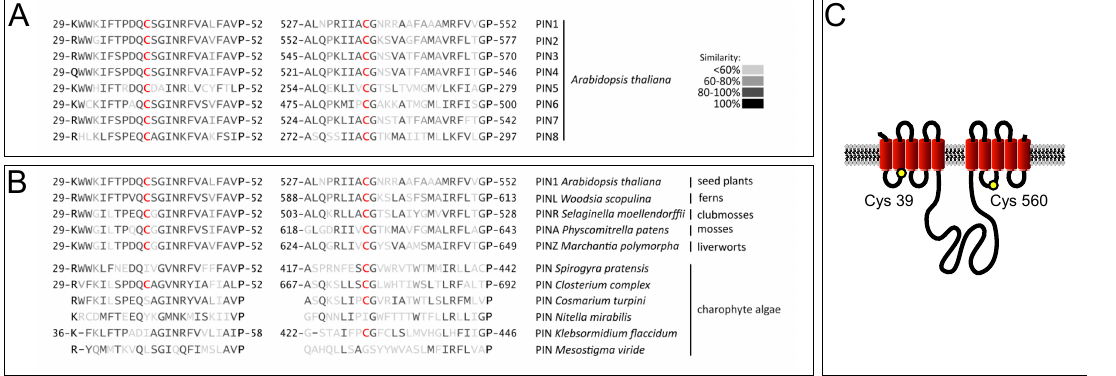
Figure 1. Conservation and predicted localization of conserved PIN cysteines. ( A ) Alignment of Arabidopsis PIN protein domains flanking conserved cysteines. Conserved cysteines are displayed in red; ( B ) Alignment of PIN protein domains flanking conserved cysteines, from representative Embryophyta and charophyte green algae. Conserved cysteines are displayed in red. Lack of indicated amino acid positions denotes incomplete sequences; ( C ) 2-D model displaying potential membrane conformation of PIN2. Red barrels represent predicted transmembrane helices, separated by loop domains (black lines). According to these predictions, both cysteines are facing the cytoplasm. The positions of Cys-39 in loop 1 and Cys-560 in loop 7 are indicated (yellow circles).